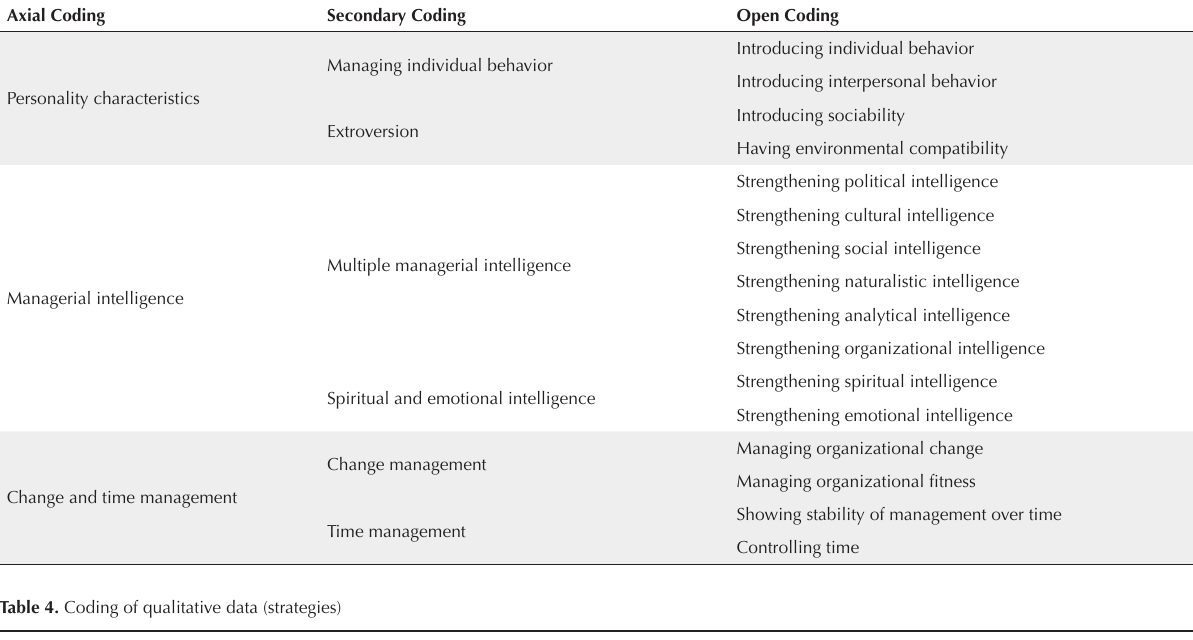
Table 4. Coding of qualitative data